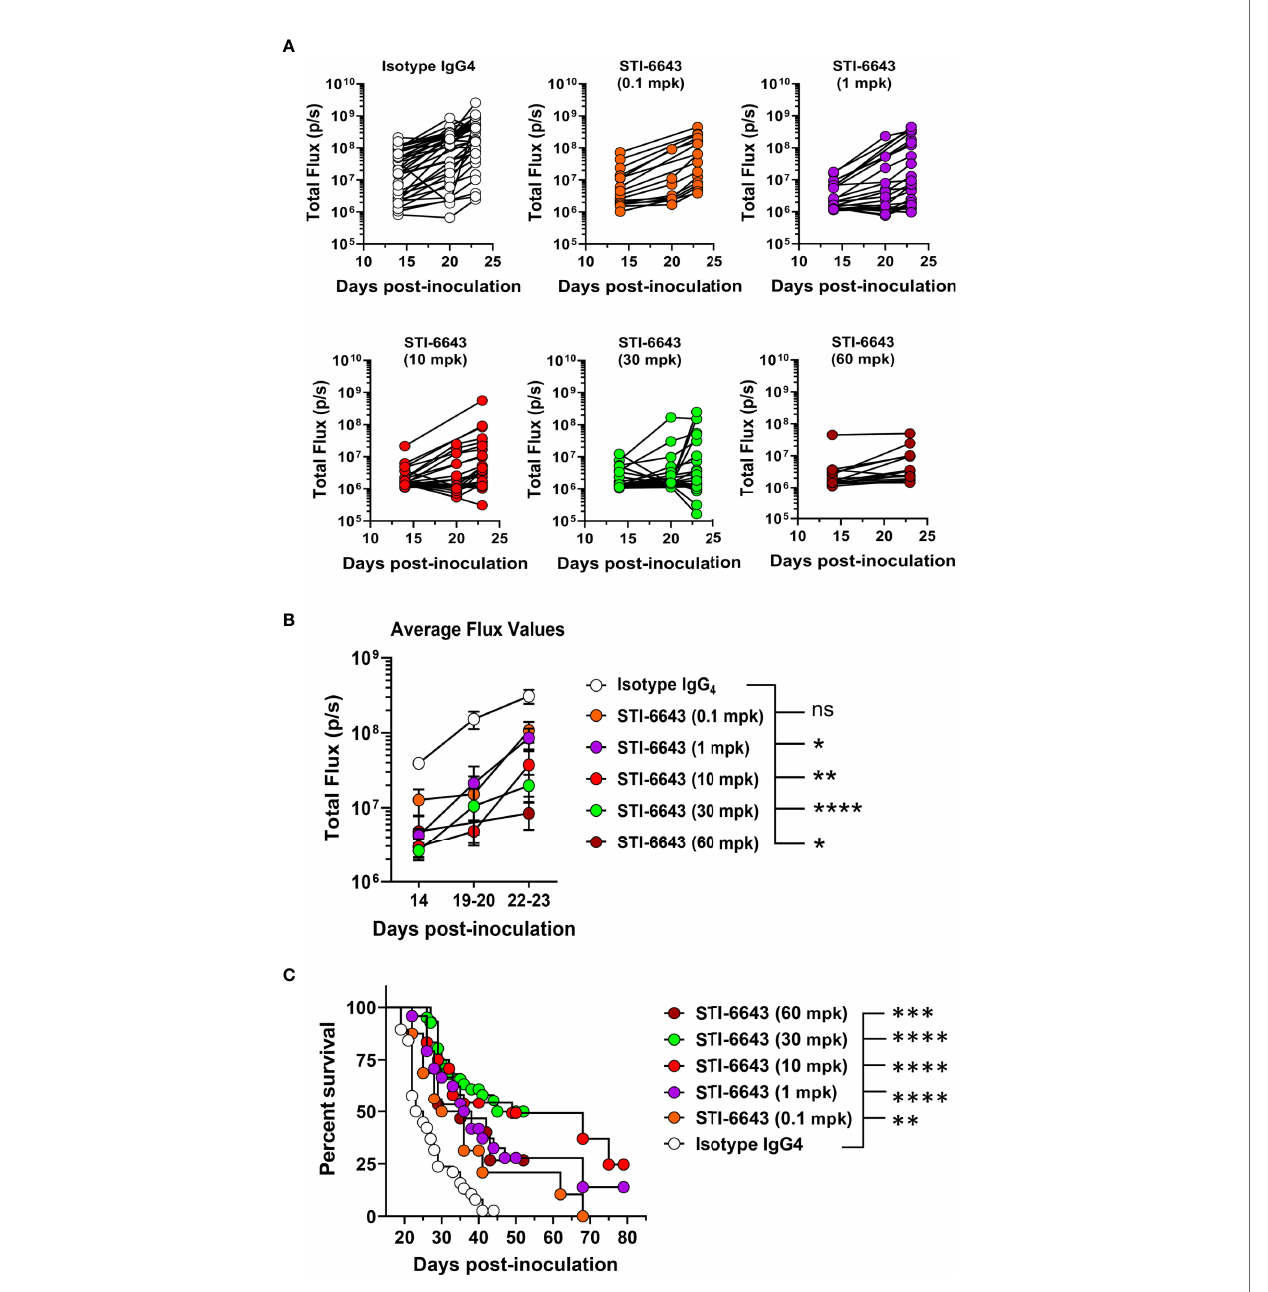
FIGURE 5 | Dose titration of anti-tumor activity of STI-6643 in the hematologic RAJI xenograft model. (A, B) Systemic tumor burden measured by bioluminescence in each group treated with STI-6643 or isotype IgG 4 (at various doses ranging from 0.1 to 60 mg/kg dose) showing total fl ux values from either (A) individual mice or (B) average data (means ± SEM). (C) Grouped analysis of survival data from 5 independent experiments comparing STI-6643-treated groups at different doses with the isotype control group. Data are pooled from four independent experiments (A, B) or fi ve (C) independent experiments. Number of animals used in each treatment group in each experiment ranged from 7-15 animals/group. A statistical analysis was conducted by comparing data from the anti-CD47 treatment groups to the isotype IgG 4 treated group (B, C) . Statistical signi fi cance assessed by two-way ANOVA (B) and log-rank Mantel-cox test (C) ; (not signi fi cant [ns], p>0.05; *p ≤ 0.05; **p ≤ 0.01; ***p ≤ 0.001; ****p ≤